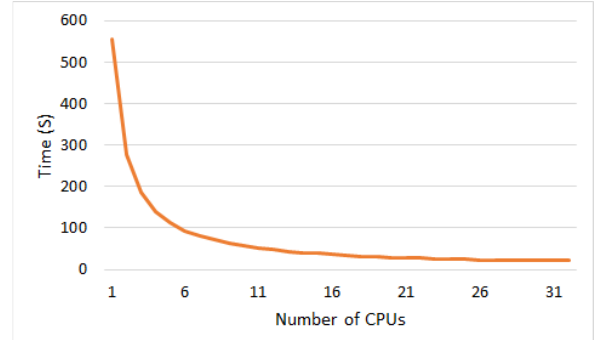
Figure 13. Comparison of time taken for multiple GPUs to process a 1600-million-pixel image in a single HPC node.